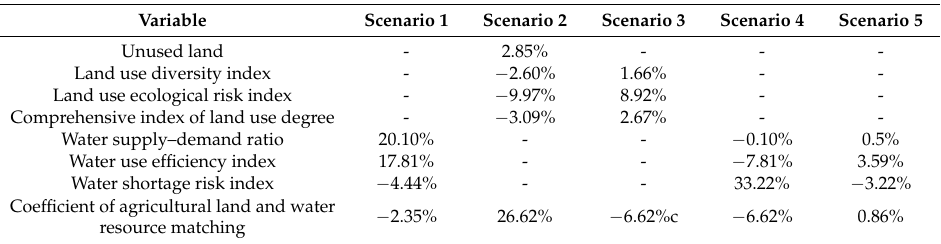
Table 3. Comparing the simulation results with the status quo under an arid climate.